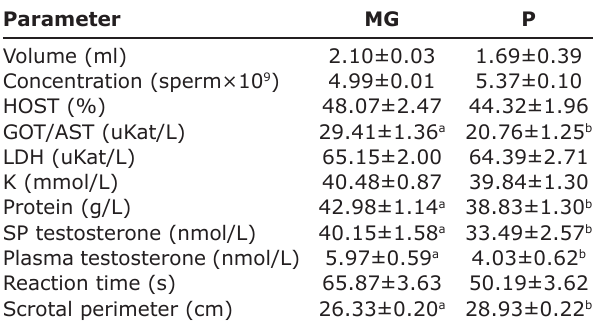
Table-4: Breed differences (mean±SEM) in semen and SP characteristics, and plasma testosterone concentrations, reaction time, and scrotal perimeter of MG and P bucks maintained under natural or artificial (2 months long days - 16 h light, 2 months short days -8 h light) photoperiod throughout the